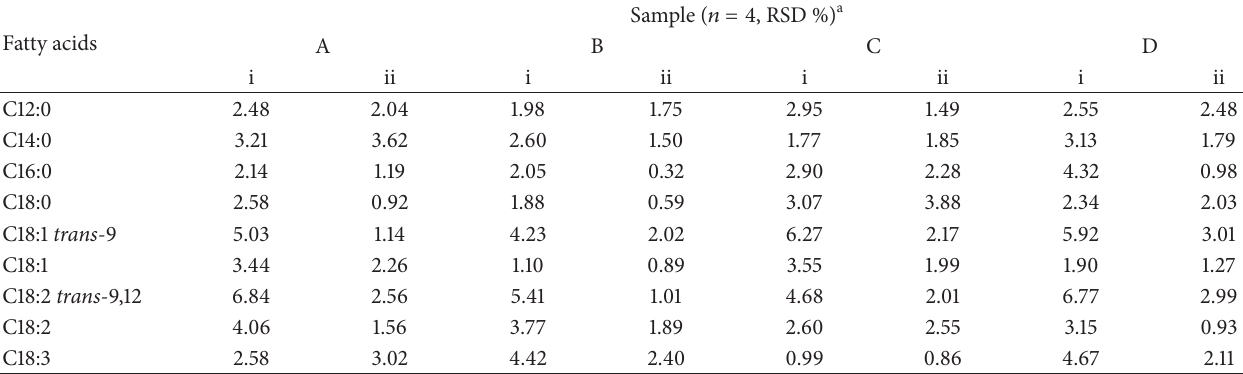
Table 5: Intraday variation (RSD, %) for four studied samples by both methods employed. Fatty acids